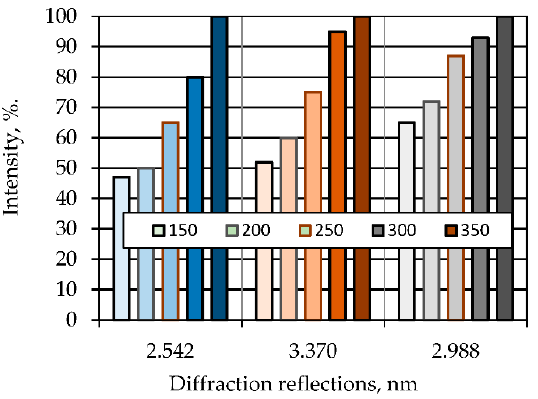
Figure 11. Effect of firing temperature on the content of crystalline phases in the liquid glass binder: 2.542 nm- α -crystobalite; 3.370 nm- β -quartz; 2.988 nm-wollastonite.